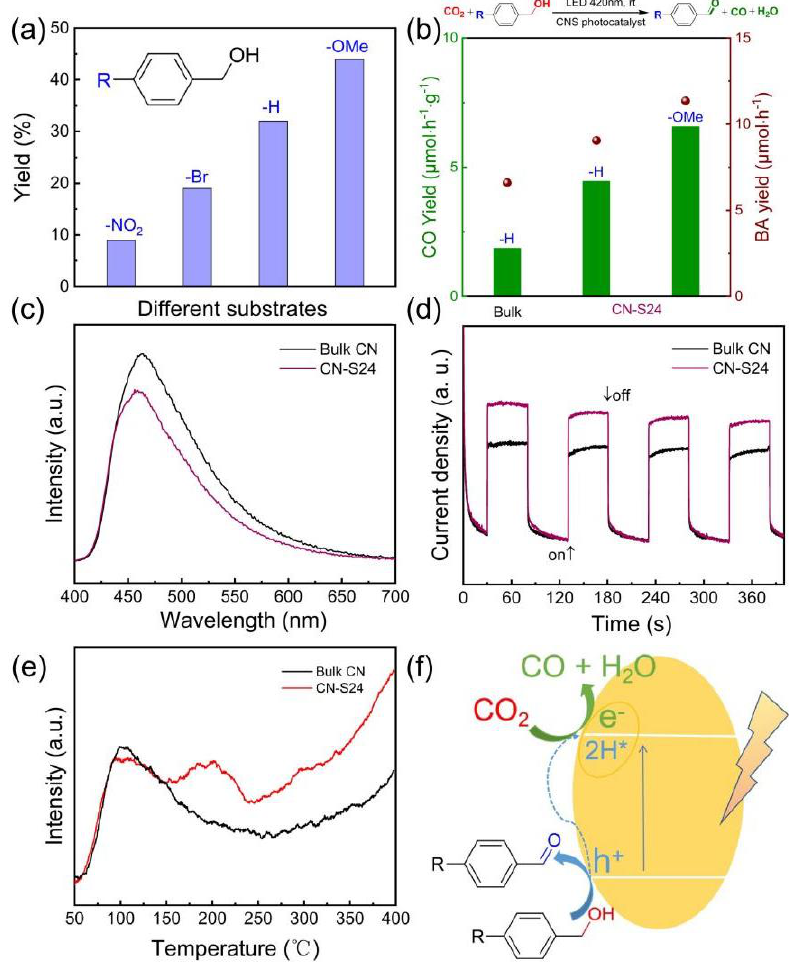
Figure 4. ( a ) Substrates with different substituent groups involved in the oxidation half-reaction over CN-S24. Reaction conditions: 0.1 mmol of substrates, 5 mL of CH 3 CN, 20 mg of catalyst, room temperature, 4 h, and Ar atmosphere. ( b ) Simultaneous CO production and alcohol oxidation over the synthesized CN-S24 and control photocatalysts. Reaction conditions: 0.1 mmol of substrates, 5 mL of CH 3 CN, 20 mg of catalyst, room temperature, 2 h, and CO 2 atmosphere. ( c ) PL spectra of bulk CN and CN-S24. ( d ) On/off photocurrent response of bulk-CN and CN-S24 in 0.5 M Na 2 SO 4 solution. ( e ) CO 2 -TPD of bulk-CN and CN-S24. ( f ) Proposed reaction pathway of CO 2 reduction to CO and alcohol oxidation on the photocatalyst.